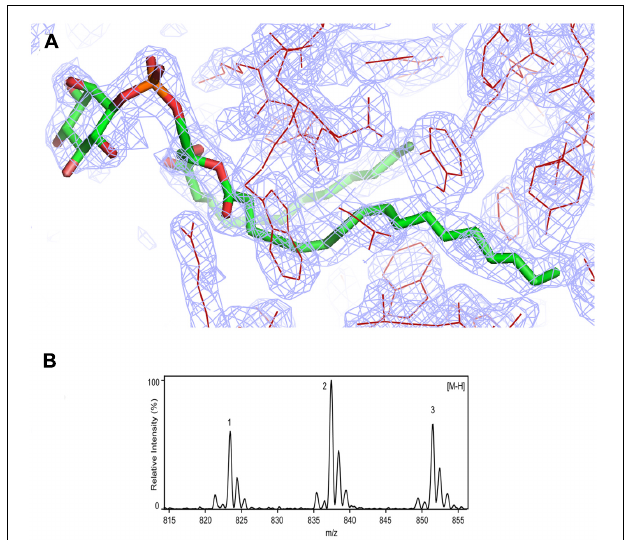
FIGURE 3 | Identification of phosphatidylinositol in Rj 3HB6H. (A) Weighted (2Fo-Fc) electron-density map of the lipid cofactor. (B) ESI-MS spectrum of lipid extract collected in negative mode. For peak assignment, see “Results”